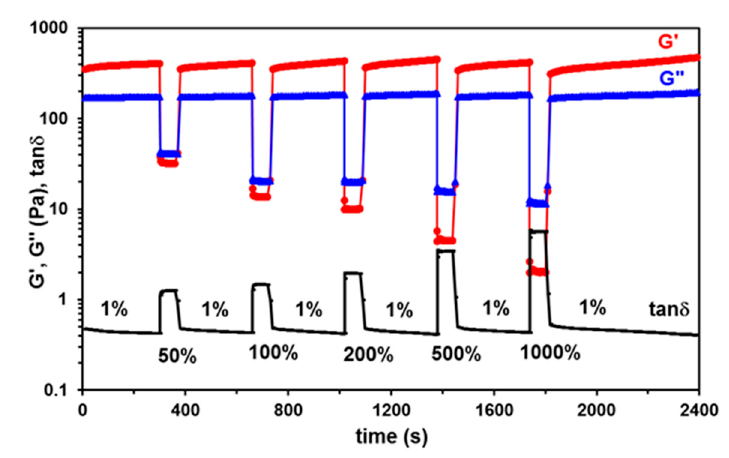
Figure 7. The self-healing ability of the sample PITAU/Alg*P2. The hydrogel was submitted to consecutive cycles of step strains at low (1%) and high (50%; 100%; 200%; 500%; 1000%) and low (1%) strains.